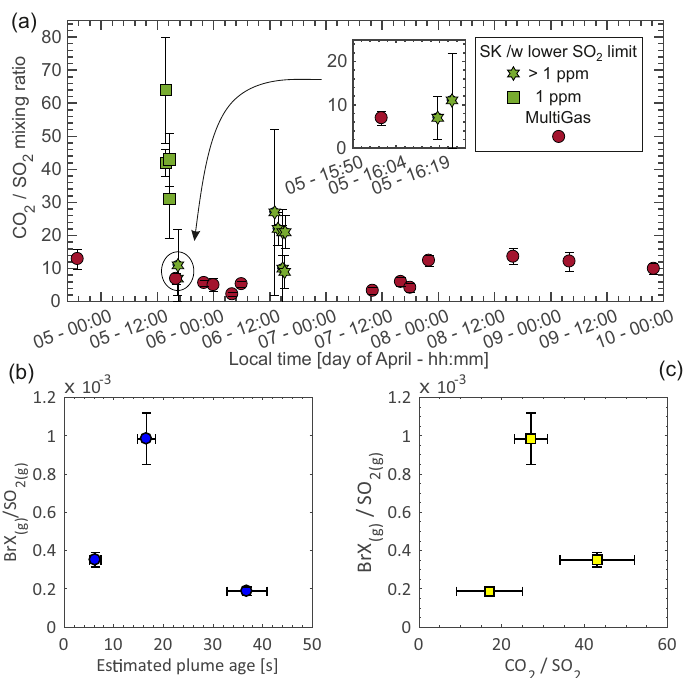
Figure 7. (a) Measured CO 2 / SO 2 gas ratios over a 5-day period by a Multi-GAS station (located east of the crater terrace) and airborne measurements with the Sunkist system at Stromboli volcano. Data point shapes indicate the lower SO 2 mixing ratio limits for the linear fit over the CO 2 vs. SO 2 data. (b) Development of the gaseous reactive bromine species over SO 2 over the estimated plume age (derived from distance to crater and estimated wind speed). (c) Gaseous reactive bromine / SO 2 ratios vs. CO 2 / SO 2 ratio.